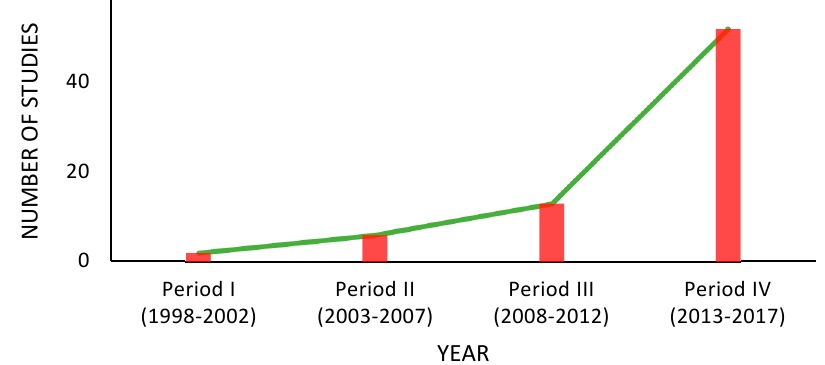
Figure 23. Percentages of different research themes regarding the structural performance of foam-filled composite panels from 1998 to 2017.